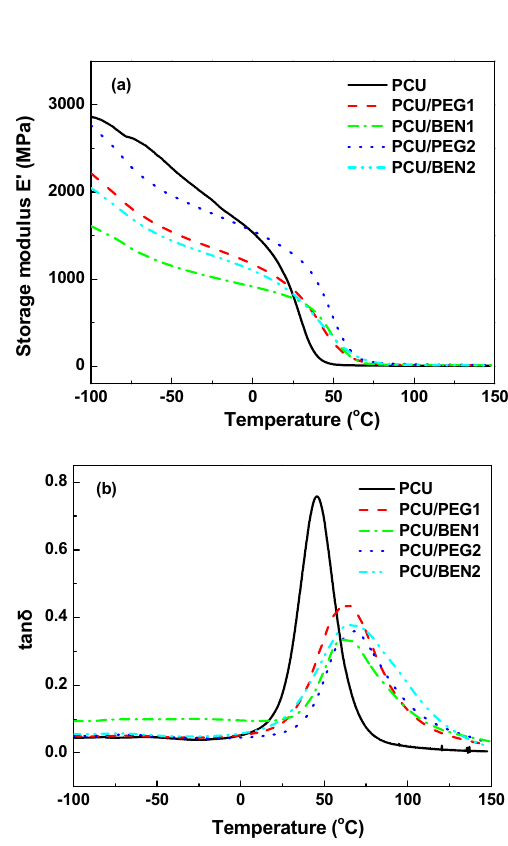
Figure 5. Storage modulus E ′ ( a ) and tanδ ( b ) over temperature for